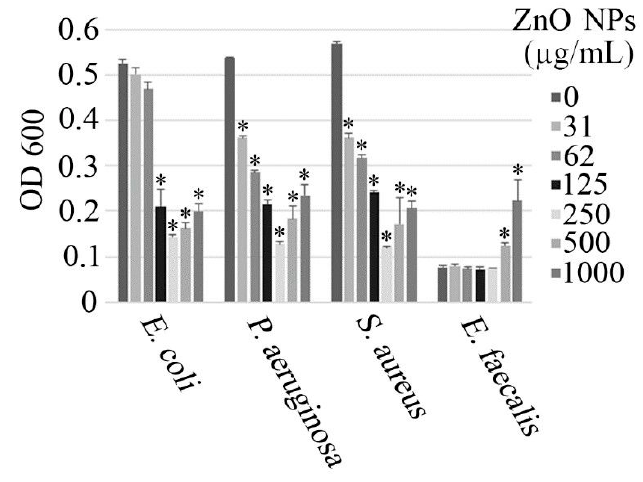
Figure 6. Antimicrobial activity of the ZnO nanorods against various Gram-positive and Gram-negative bacterial strains. OD, optical density; ZnO NPs, zinc oxide nanoparticles.